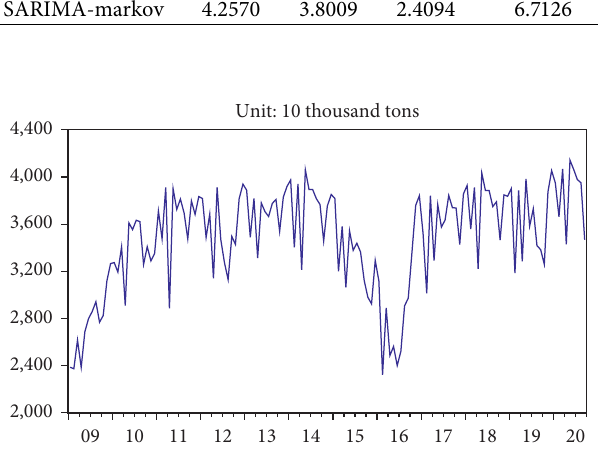
Figure 9: Prediction result of the SARIMA ( 4 , 1 , 2 )( 1 , 1 , 1 ) 12 model outside the sample period.